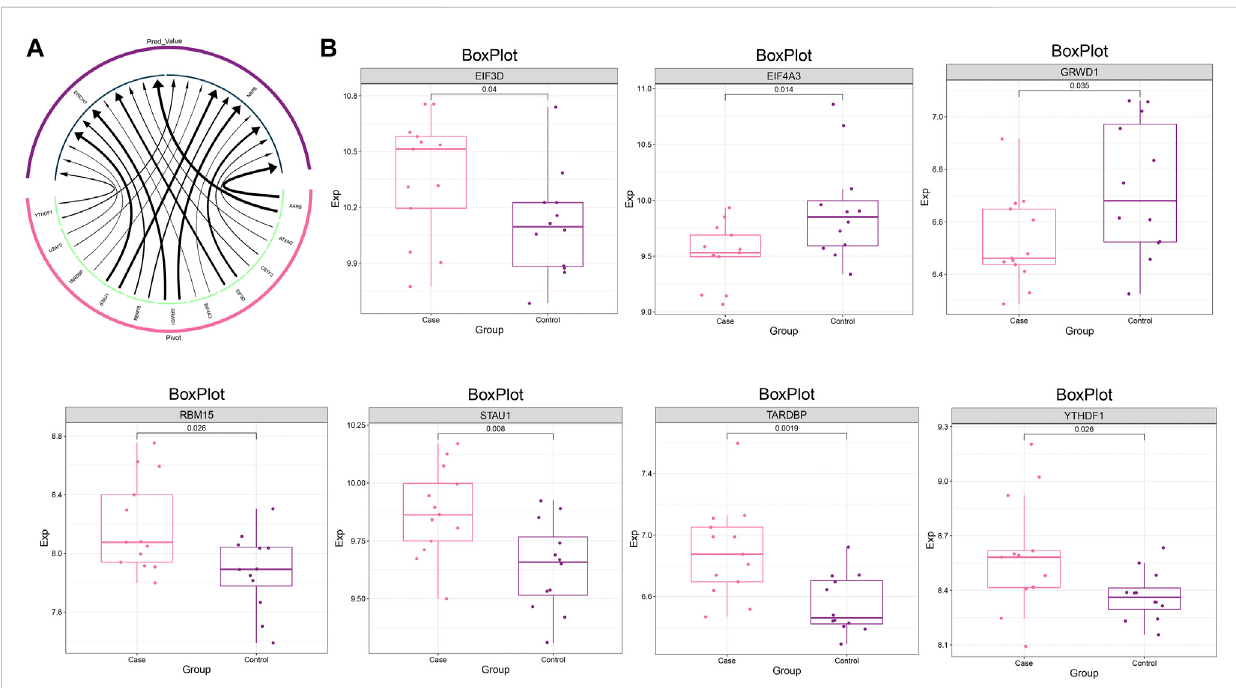
FIGURE 6 Upstream regulators of the dysregulated gene co-expression module. (A) Circular network plot demonstrating the regulatory effect of RBP on MG dysregulated gene co-expression module-based Lasso model genes. (B) Box plot demonstrating the expression level of